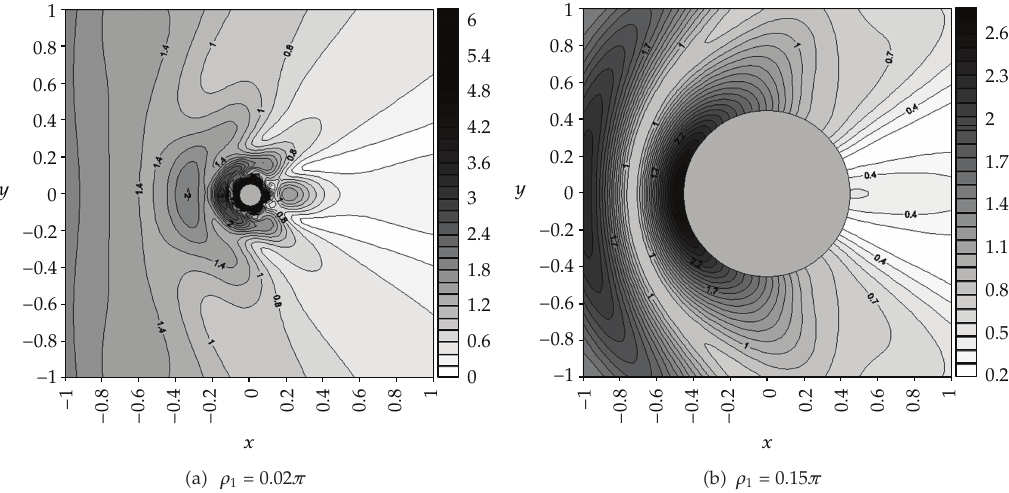
Figure 5: E ff ects of island on wave scattering for α (cid:4) 2 (cid:2) ρ 0 (cid:4) 0 . 2 π , f p (cid:4) 1, n 0 (cid:4) 0 . 5 (cid:3) . top of a shoal for arbitrary geometry described by two independent parameters. The e ff ect of key parameters on waves scattering was investigated based on numerical calculations from the analytic